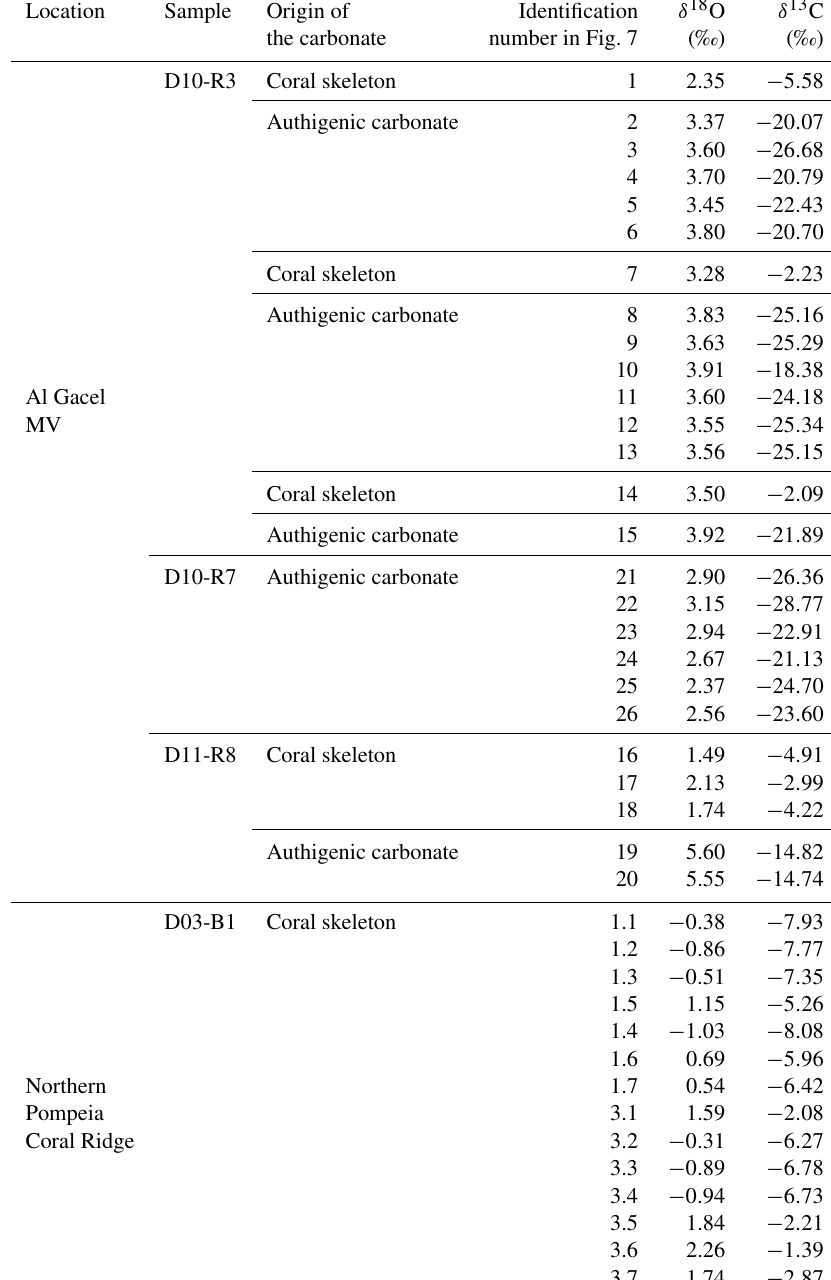
Table 4. Stable carbon and oxygen isotopes ( δ 13 C, δ 18 O) of samples from the Al Gacel MV and the northern Pompeia Coral